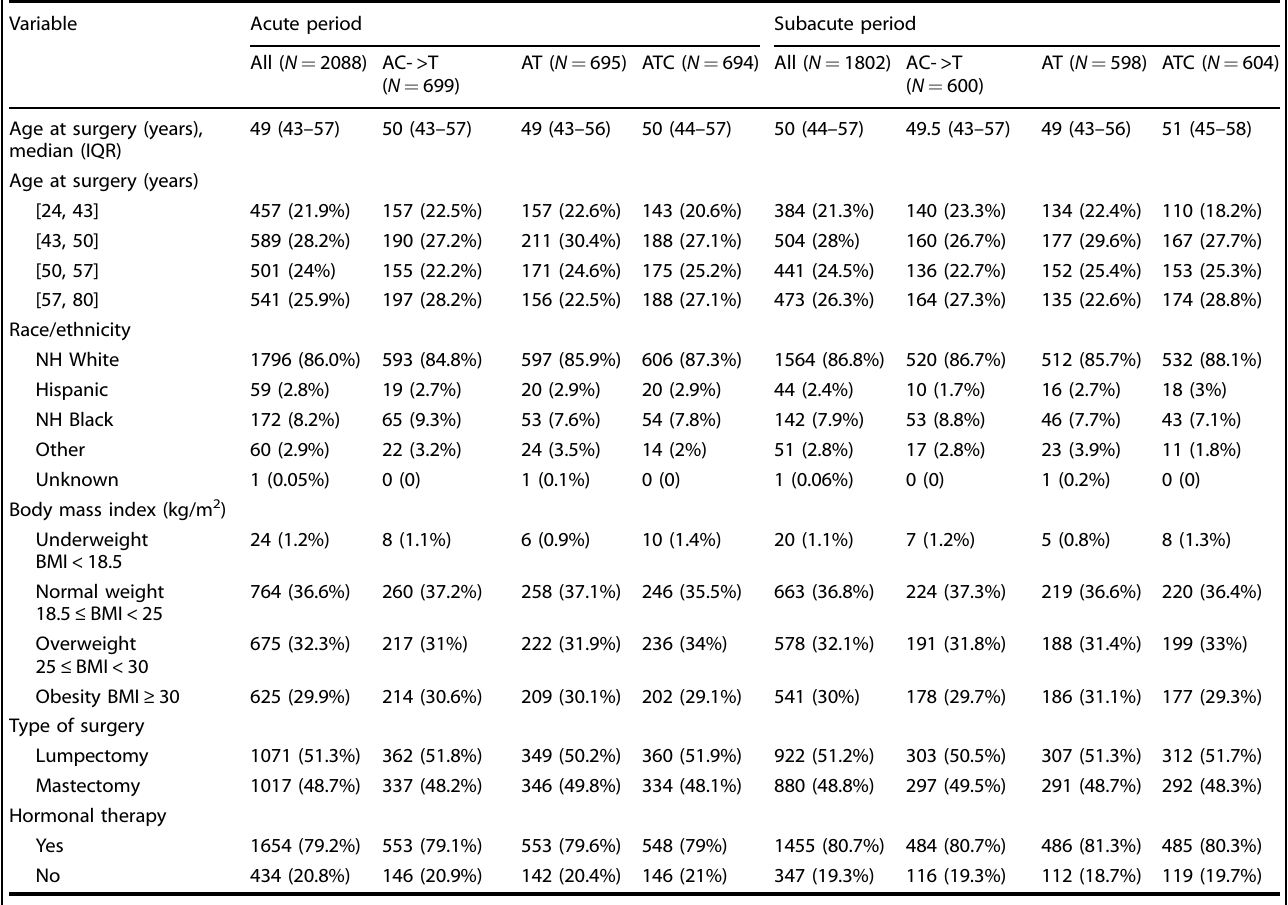
Table 1. Baseline patient characteristics strati fi ed by treatment group and